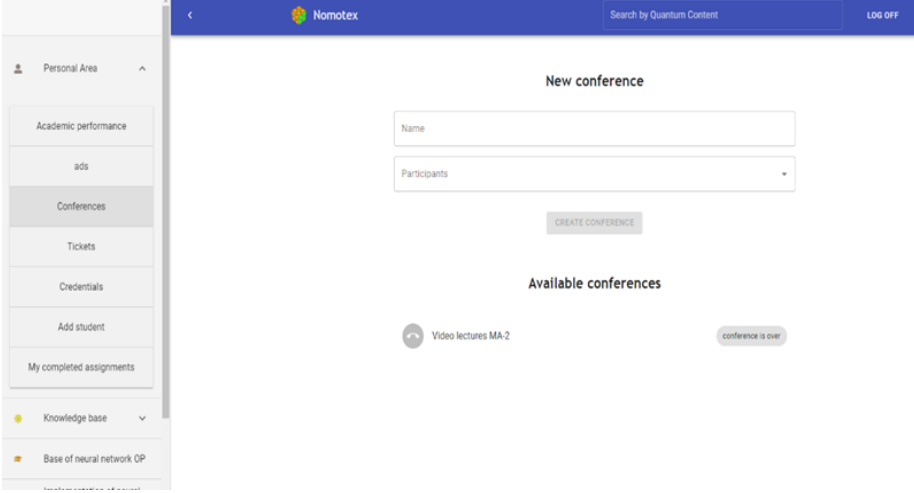
Fig. 4. Window of functional «Video-Conference» in the Nomotex